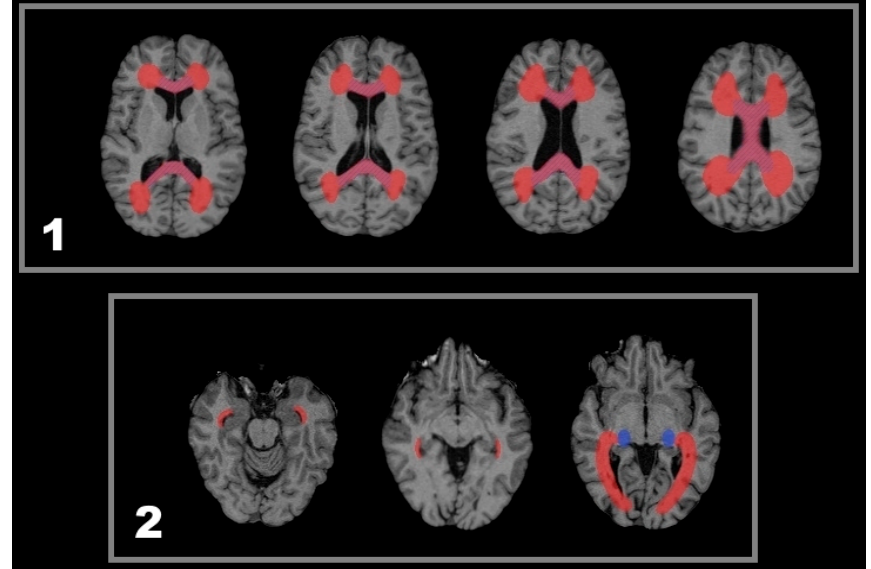
Figure 5. Sketch of anatomical regions of interest regarding the statistical analysis of lesion-related volume decrease. ( 1 ) The red coloured region delineates a WM region that contains callosal fibres including an adjacent delta-like extension and was searched for lesions. The region investigated for callosal atrophy is drafted in blue hachures; ( 2 ) In these exemplary slices, a red draft delineates the region covering all three bundles of the optic radiation including the entire lateral and superior wall of the inferior horn of the lateral ventricles [36–40]. For the LGN, a high inter-individual variability is known regarding both size and location [37]. Therefore, a region of the posterior thalamus containing the LGN derived from a population map by Bürgel et al. was approximated for each patient so as to assess LGN atrophy consistently (blue draft).